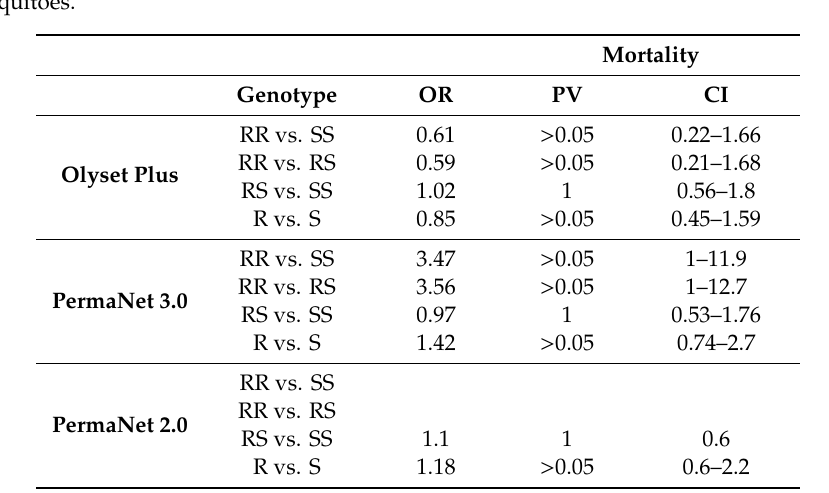
Figure 3. Impact of the L119F -GSTe2 mediated metabolic resistance on bednet efficacy for blood feeding ability: ( A ) Genotype distribution of L119F- GSTe2 between blood fed and unfed mosquitoes after exposure to Olyset showing a significant increased ability to blood feed for resistant mosquitoes; ( B ) Genotype distribution of L119F- GSTe2 between blood fed and unfed mosquitoes after exposure to Olyset Plus showing a significant increased ability to blood feed for resistant; ( C ) Genotype distribution of L119F- GSTe2 between blood fed and unfed mosquitoes after exposure to PermaNet 2.0 showing an inverse marginal increased ability to blood feed for homozygote susceptible SS compared to homozygote resistant RR ( p < 0.05); ( D ) Genotype distribution of L119F- GSTe2 between blood fed and unfed mosquitoes after exposure to PermaNet 3.0 showing an increased ability to blood feed of susceptible mosquitoes compared to resistant mosquitoes (R vs. S: OR = 0.29 p < 0.05). Table 4. Impact of L119F-GSTe2 mutation on the ability of various insecticide-treated nets to kill